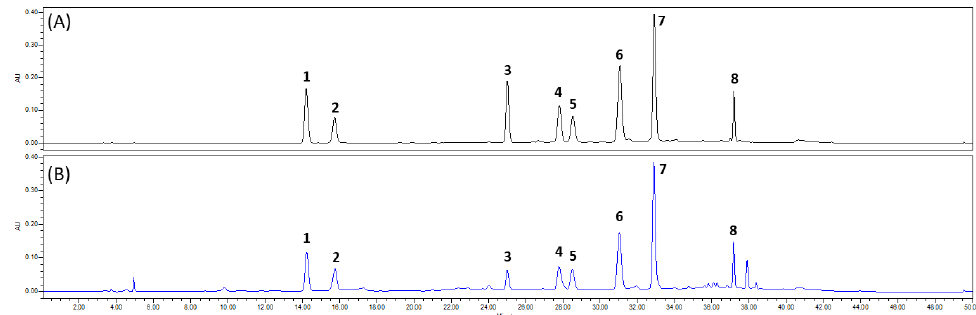
Figure 4. HPLC chromatograms of the eight marker compounds ( A ) and the extract of I. rotunda twigs ( B ) detected at 254 nm. Identified compounds are syringin ( 1 ; t R 14.19 min), chlorogenic acid ( 2 ; t R 15.69 min), rutin ( 3 ; t R 24.96 min), rotundarpenoside B ( 4 ; t R 27.73 min), 3,4-dicaffeoylquinic acid ( 5 ; t R 28.43 min), 3,5-dicaffeoylquinic acid ( 6 ; t R 30.96 min), 4,5-dicaffeoylquinic acid ( 7 ; t R 32.84 min), and 3,4,5-tricaffeoylquinic acid ( 8 ; t R 37.18 min).